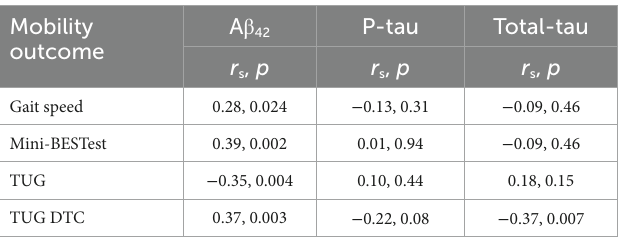
TABLE 3 Spearman’s rank correlation coefficients ( r s ) between mobility outcomes and CSF AD core biomarkers ( n = 64).